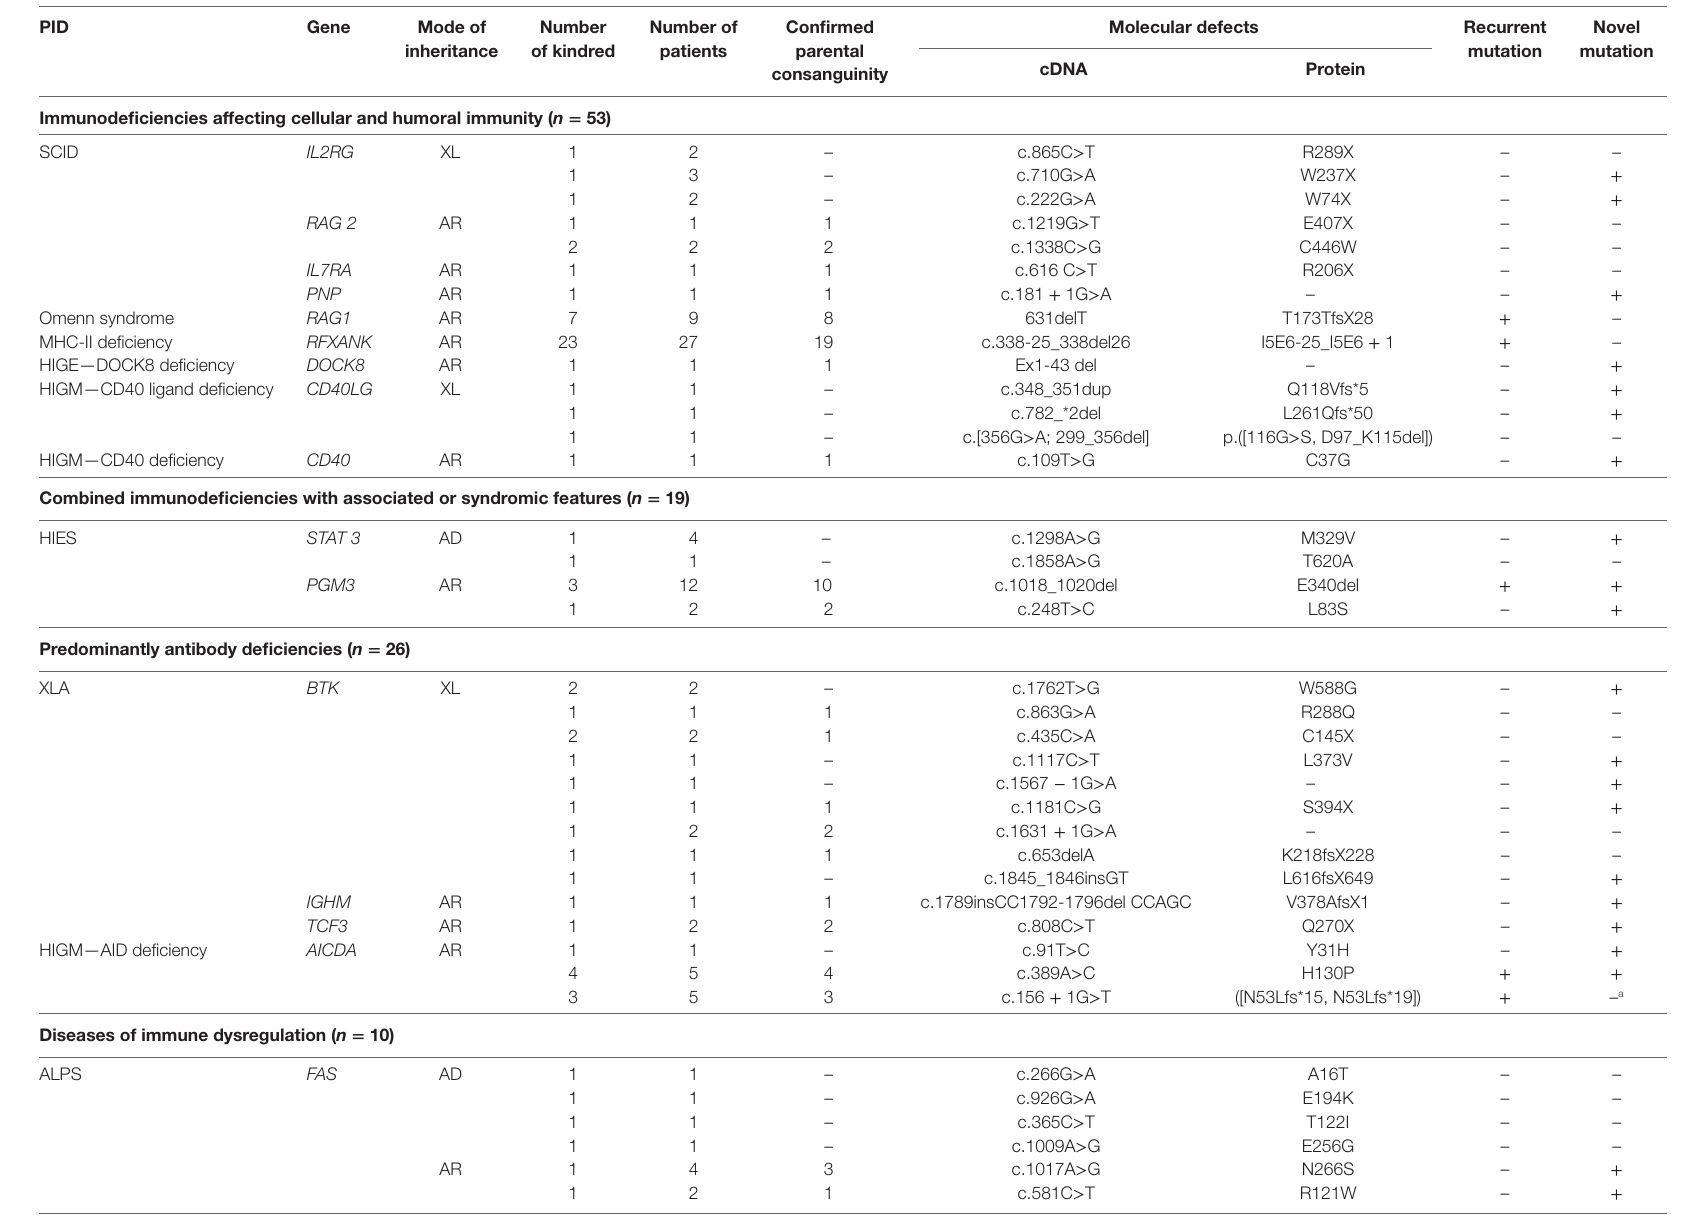
TABLe 1 | Mode of inheritance and molecular studies in the 170 Tunisian patients investigated.